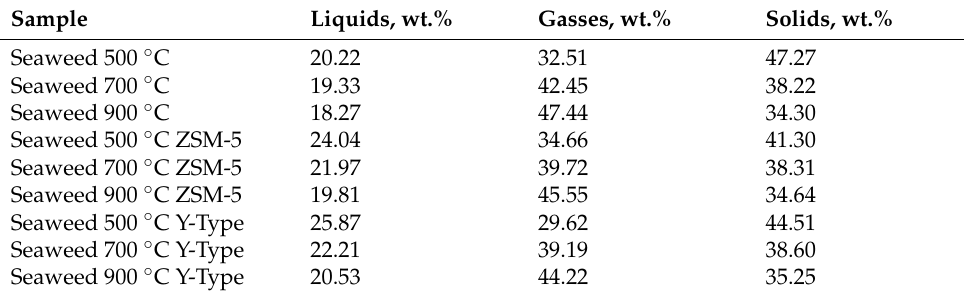
Table 3. Yields of the formed pyrolysis